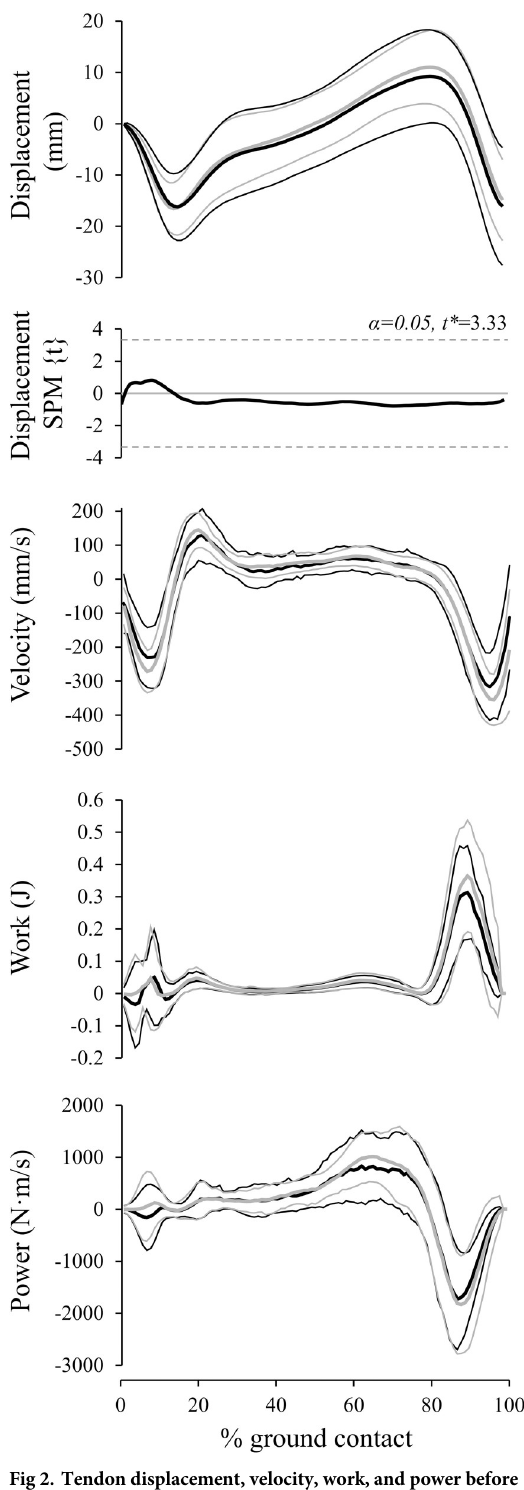
Fig 2. Tendon displacement, velocity, work, and power before (black, thick) and after (grey, thick) training protocols ( ± 1 s.d. thin lines). Dependent variables represent averaged data from all participants during the stance phase of the gait cycle. SPM analysis demonstrates lack of change in displacement from pre-post training.